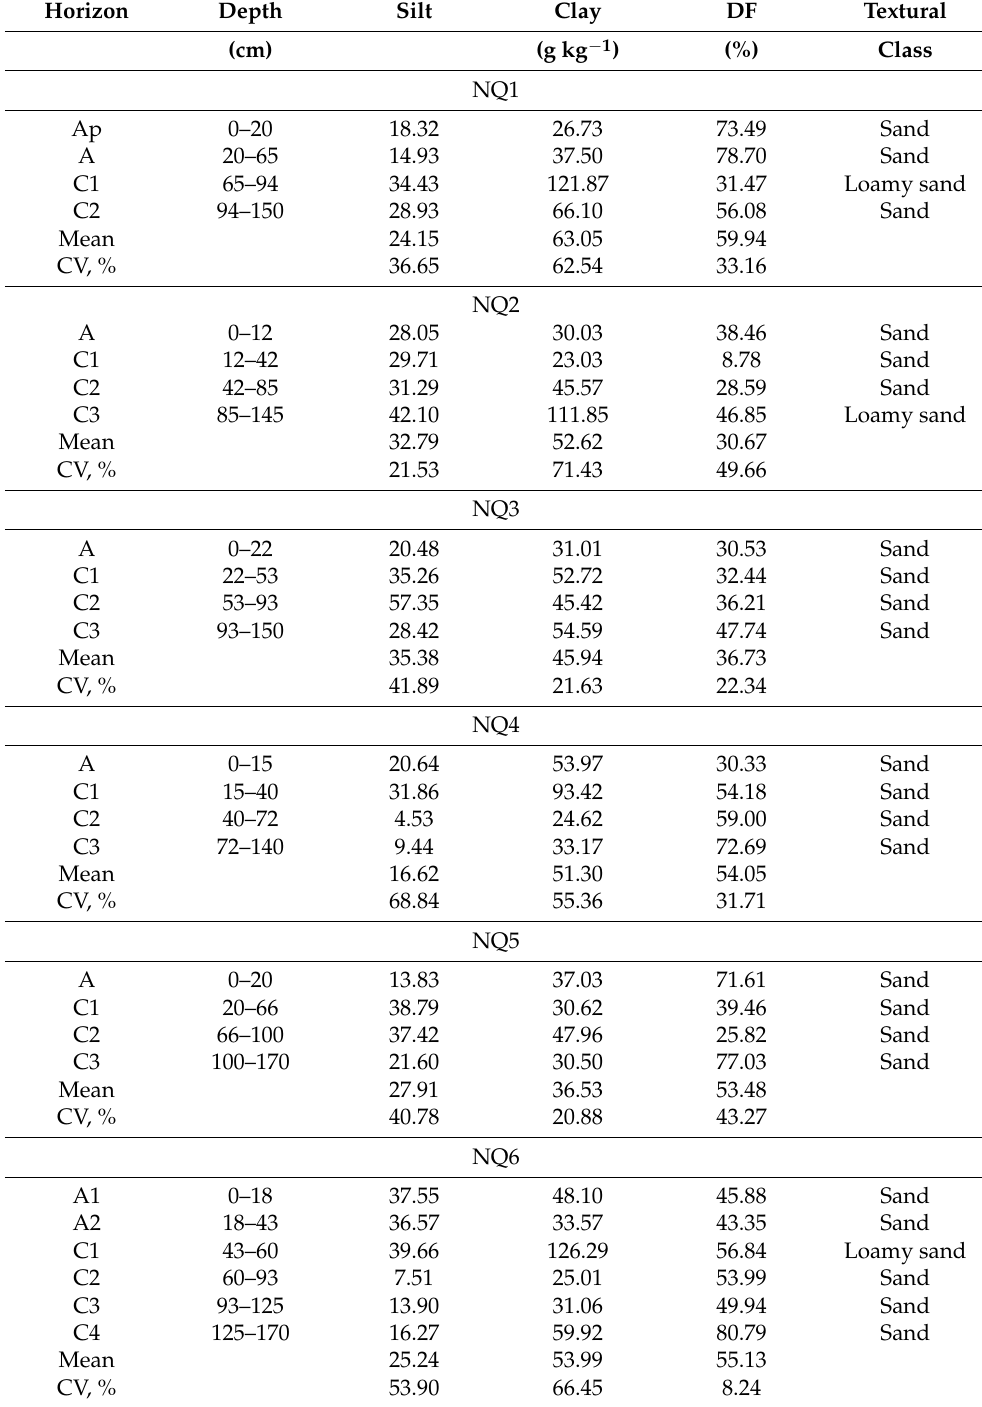
Table 3. Silt and clay content, degree of flocculation (DF), and textural class [24] of the Quartzipsam- ments profiles of the Southwest of Rio Grande do Sul State, southern